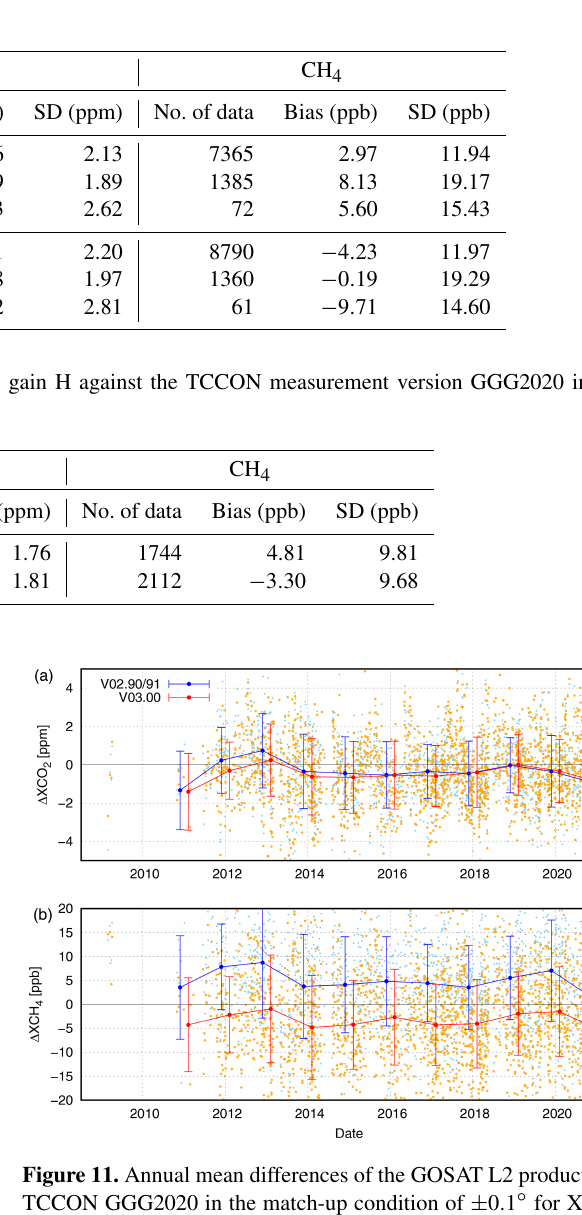
Table 6. Validation results of V03.00 and V02.90/91 against the TCCON measurements version GGG2020 with the match-up condition of ± 2 ◦ . The mean values of the differences between TCCON and GOSAT (bias) and their standard deviations (SD) are shown for each combination of surface conditions and gain settings.